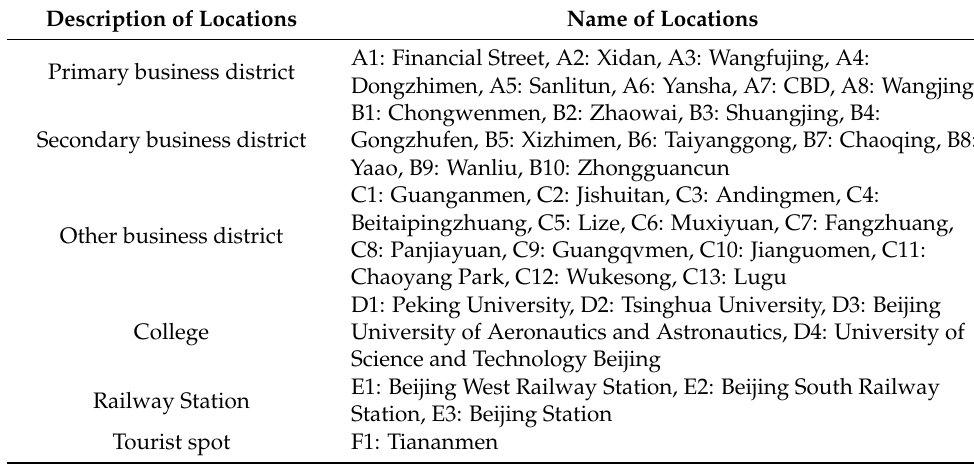
Table 1. Descriptions of the highlighted locations in Figure 1.